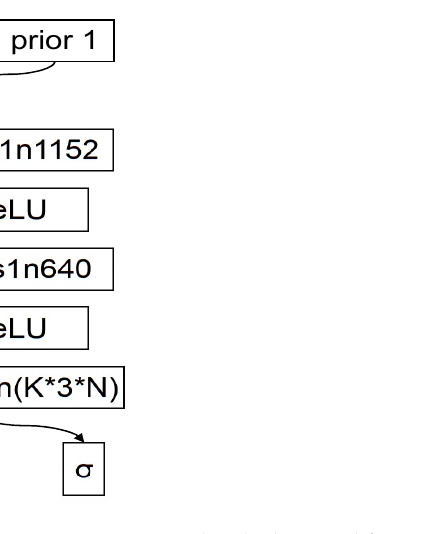
Figure 6. The parameter estimator network, which is used for estimating the parameter of